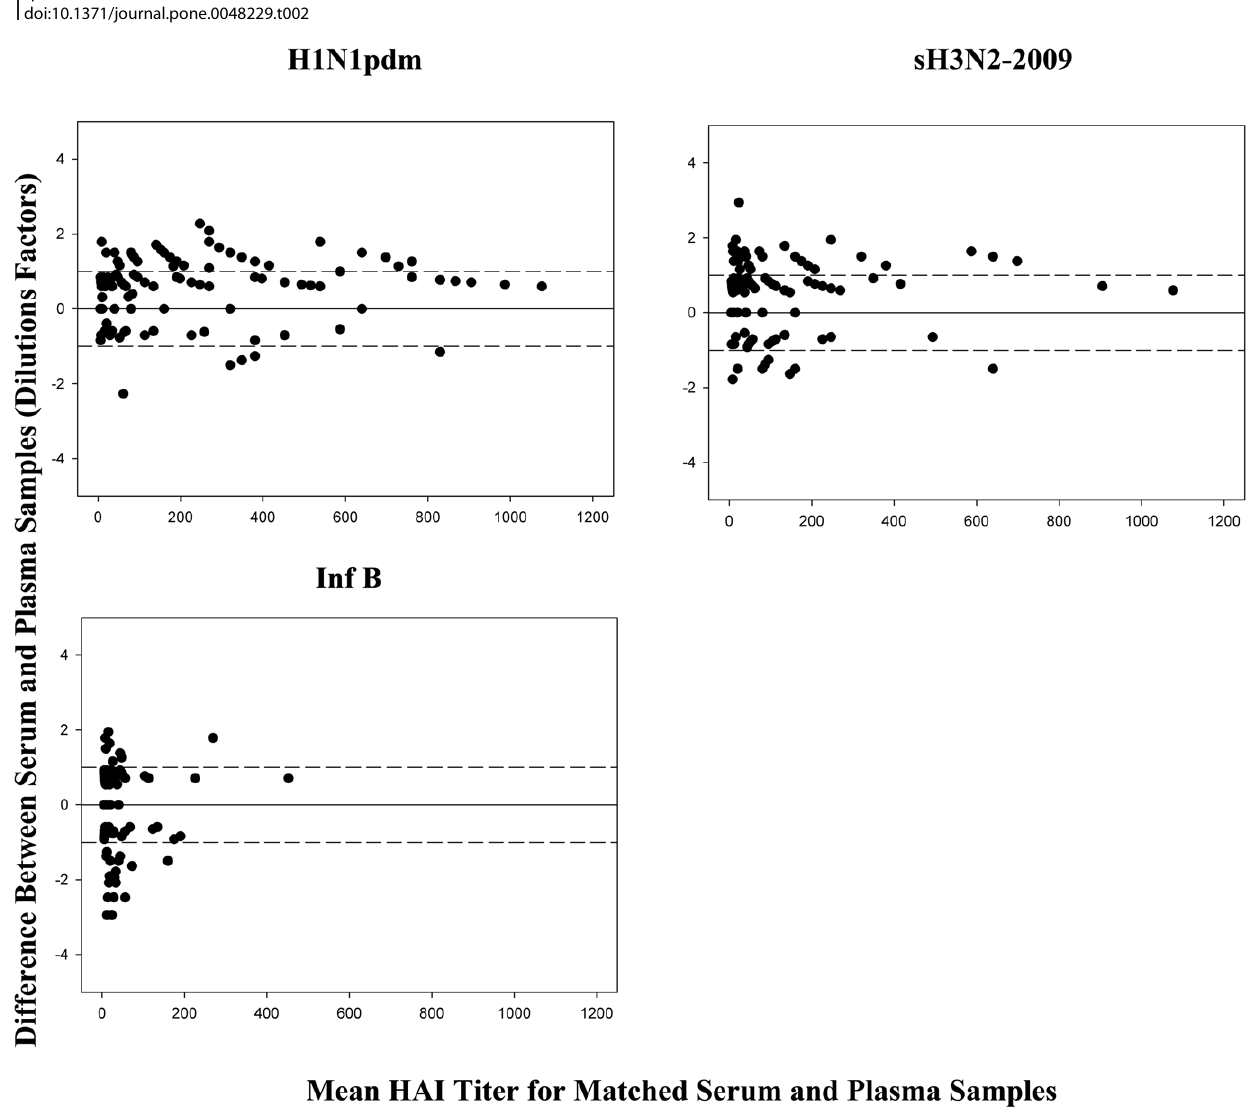
Figure 2. Bland-Altman Plots for 149 paired serum-heparinized plasma v1 and v4 samples. Dashed lines denote the limit of agreement (all HAI values within 1 dilution factor). Overall agreement between the serum and plasma samples was $ 80%.